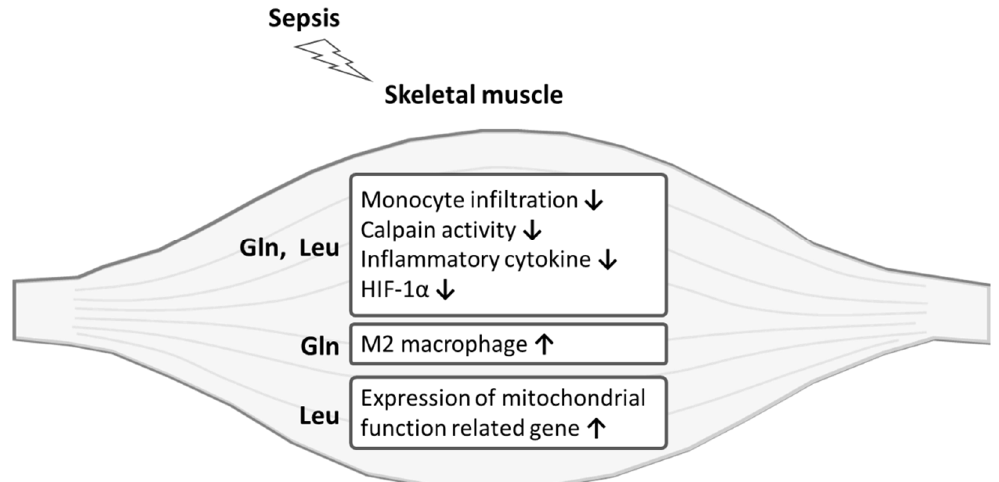
Figure 7. Schematic overview of the protective effects L -glutamine (Gln) and L -leucine (Leu) on sepsis-induced skeletal muscle injuries. HIF, hypoxia-inducible factor.